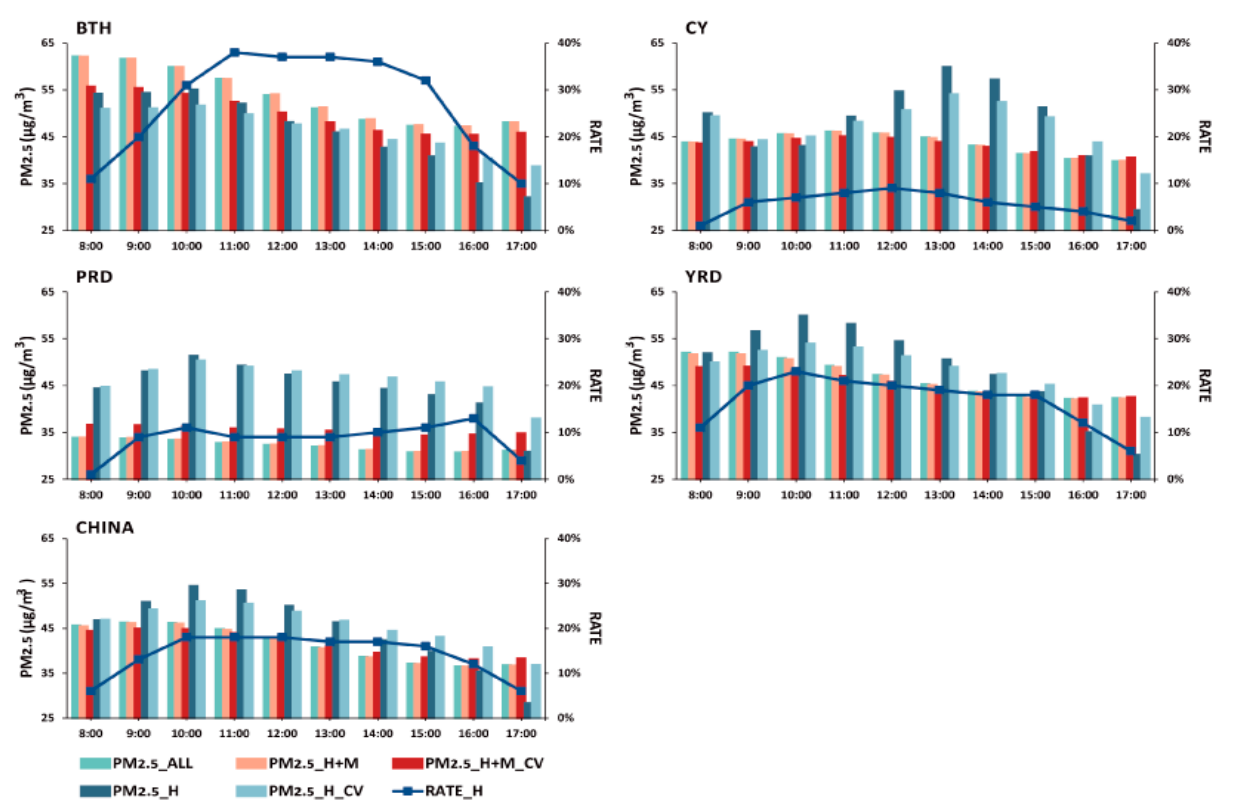
Figure 7. Time series of PM 2.5 concentrations of all monitoring sites (PM_ALL), PM 2.5 observations matched with AOD H (PM 2.5 _H), AOD H+M (PM 2.5 _H+M), AOD H -derived (PM 2.5 _H_CV), AOD H+M -derived PM 2.5 (PM 2.5 _H+M_CV) and observation rates of Himawari-8 in China and four typical regions.